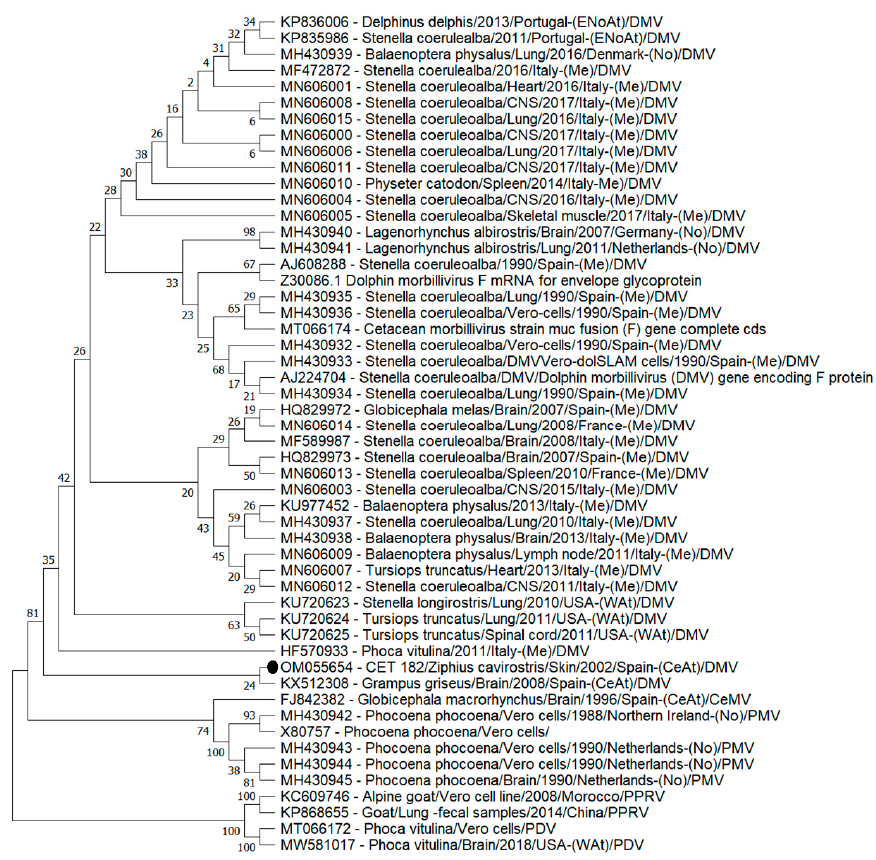
Figure 3. Maximum likelihood phylogenetic tree for the nucleotide sequences of the fusion protein (F) gene. The phyloge- netic tree consisting of 52 sequences from reported cases of cetacean morbillivirus. To construct the tree, we designed the